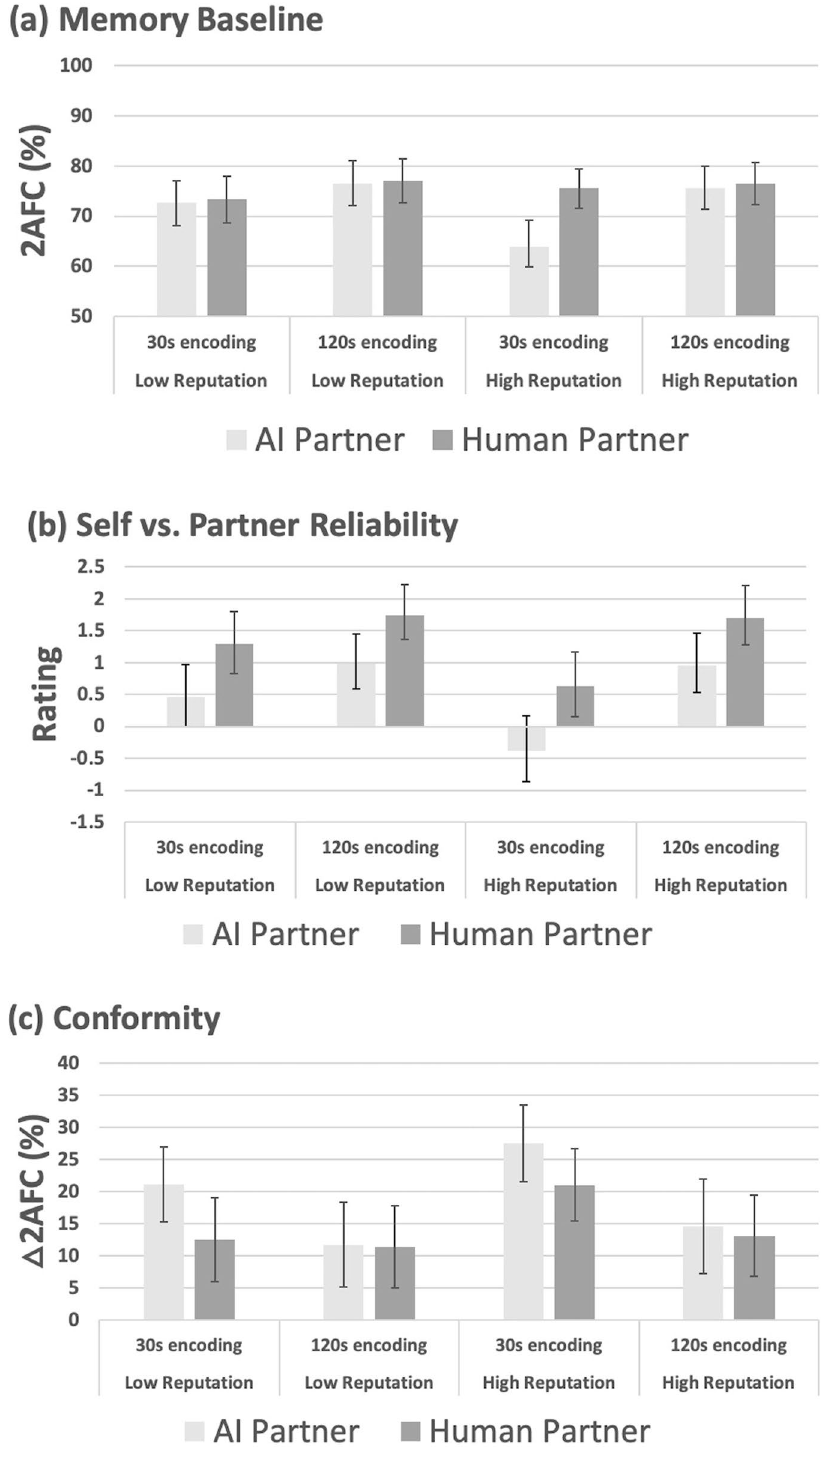
Figure 1. Data for Experiment 1 (Source credibility effects). ( a ) Mean percentage baseline memory 2-alternative forced choice (2AFC) performance (± 95% CI), in the AI (light-grey) vs. human (dark-grey) groups following 30 s or 120 s viewing time at encoding, for low (six out of ten correct) vs. high reputation (eight out of ten correct) AI or human partner. ( b ) Mean perceived reliability ratings (± 95% CI) for self vs. AI or human partner. Positive values reflect relative reliability of self, negative values reflect relative reliability of AI or human partner (zero indicates equivalent perceived reliability). ( c ) Change in mean percentage 2AFC ( △ 2AFC, ± 95% CI) performance induced by conformity to accurate minus errant information following 30 s vs. 120 s viewing time at encoding, for AI vs. human partners of low vs. high